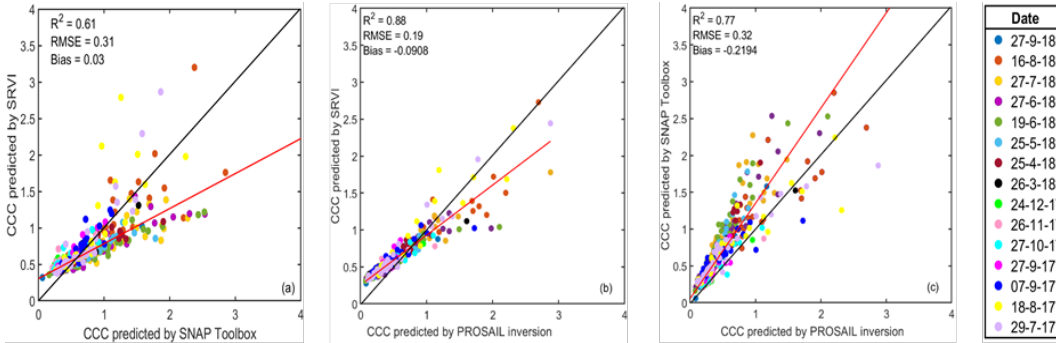
Figure 10. The goodness of fit between CCC predicted values by SRVI vs. SNAP toolbox ( a ), PROSAIL inversion vs. SRVI ( b ), and PROSAIL inversion vs. SNAP toolbox ( c ) for 15 dates of Sentinel-2 data available for the La Camargue pilot site. The lines in black show the 1:1 relationship, whereas the lines in red, designates the relationship between the CCC estimates by the selected algorithms.